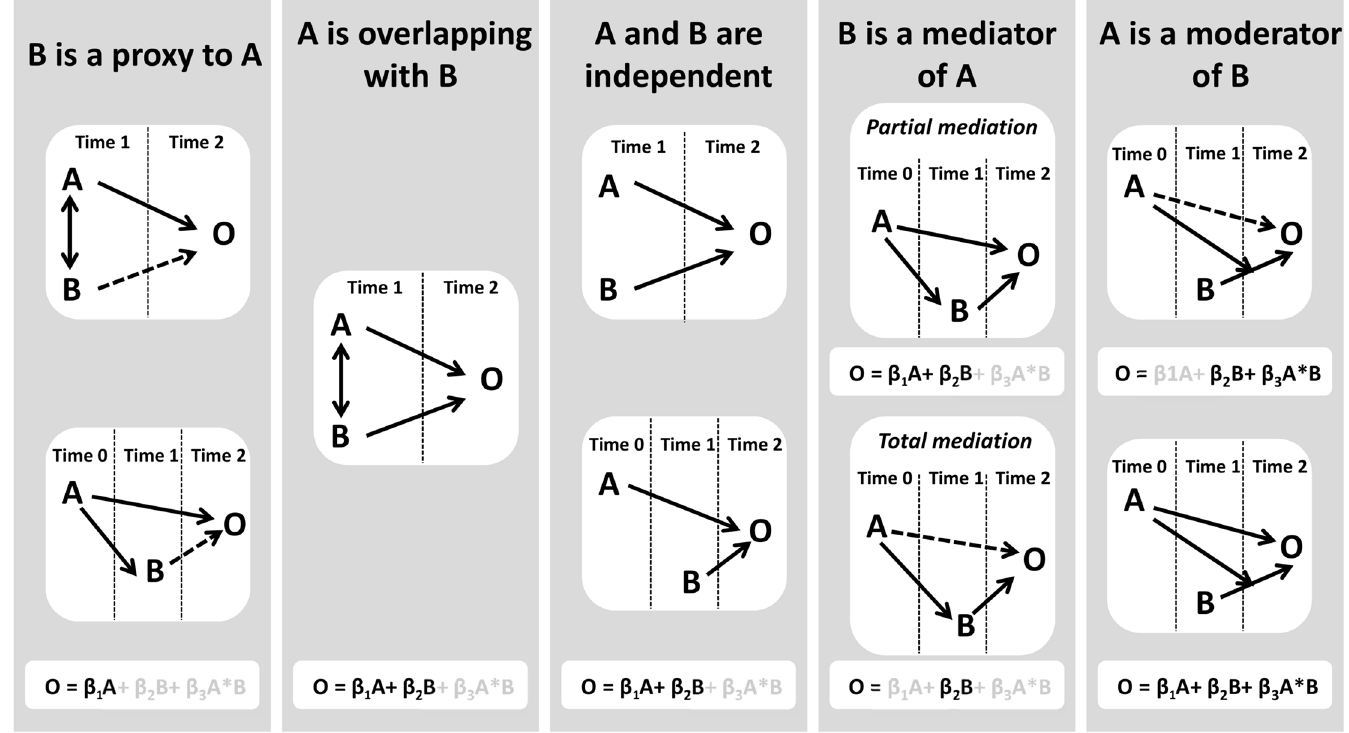
Fig 2. Risk factors classification. A and B are the risk factors. O is the outcome. The single/double-headed arrow between A and B indicates a correlation. The solid (or dotted) arrow between a risk factor and O indicates a significant (or insignificant) association adjusting for the other risk